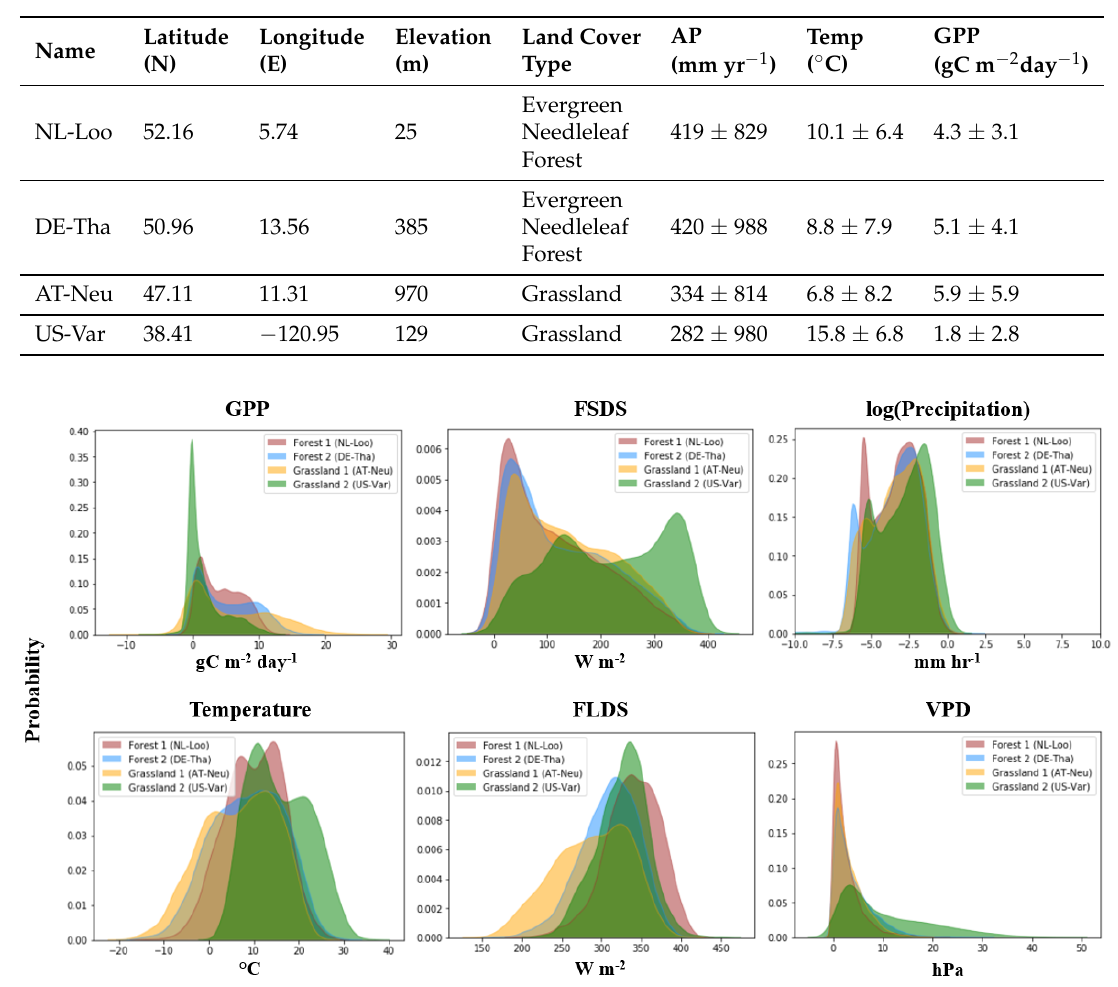
Figure 3. Probability densities of the observed climate drivers at the four FLUXNET sites included in this study. Red and orange are grassland sites while blue and green are evergreen needleleaf forest